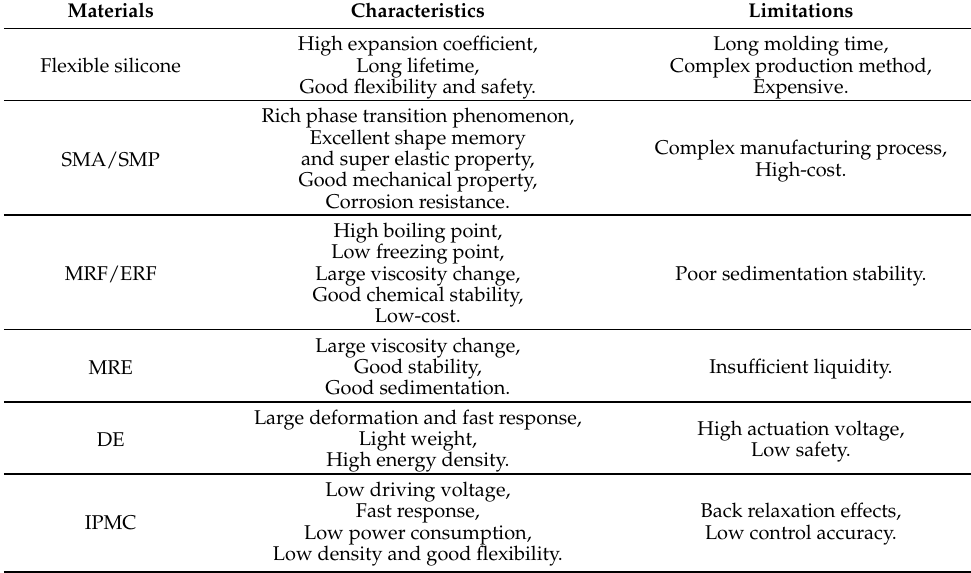
Table 3. The characteristics and limitations of commonly used soft materials.